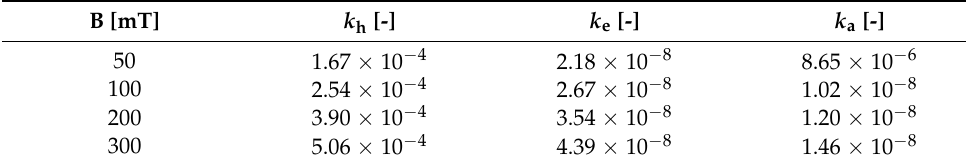
Table 1. Steinmetz coefficients after initial